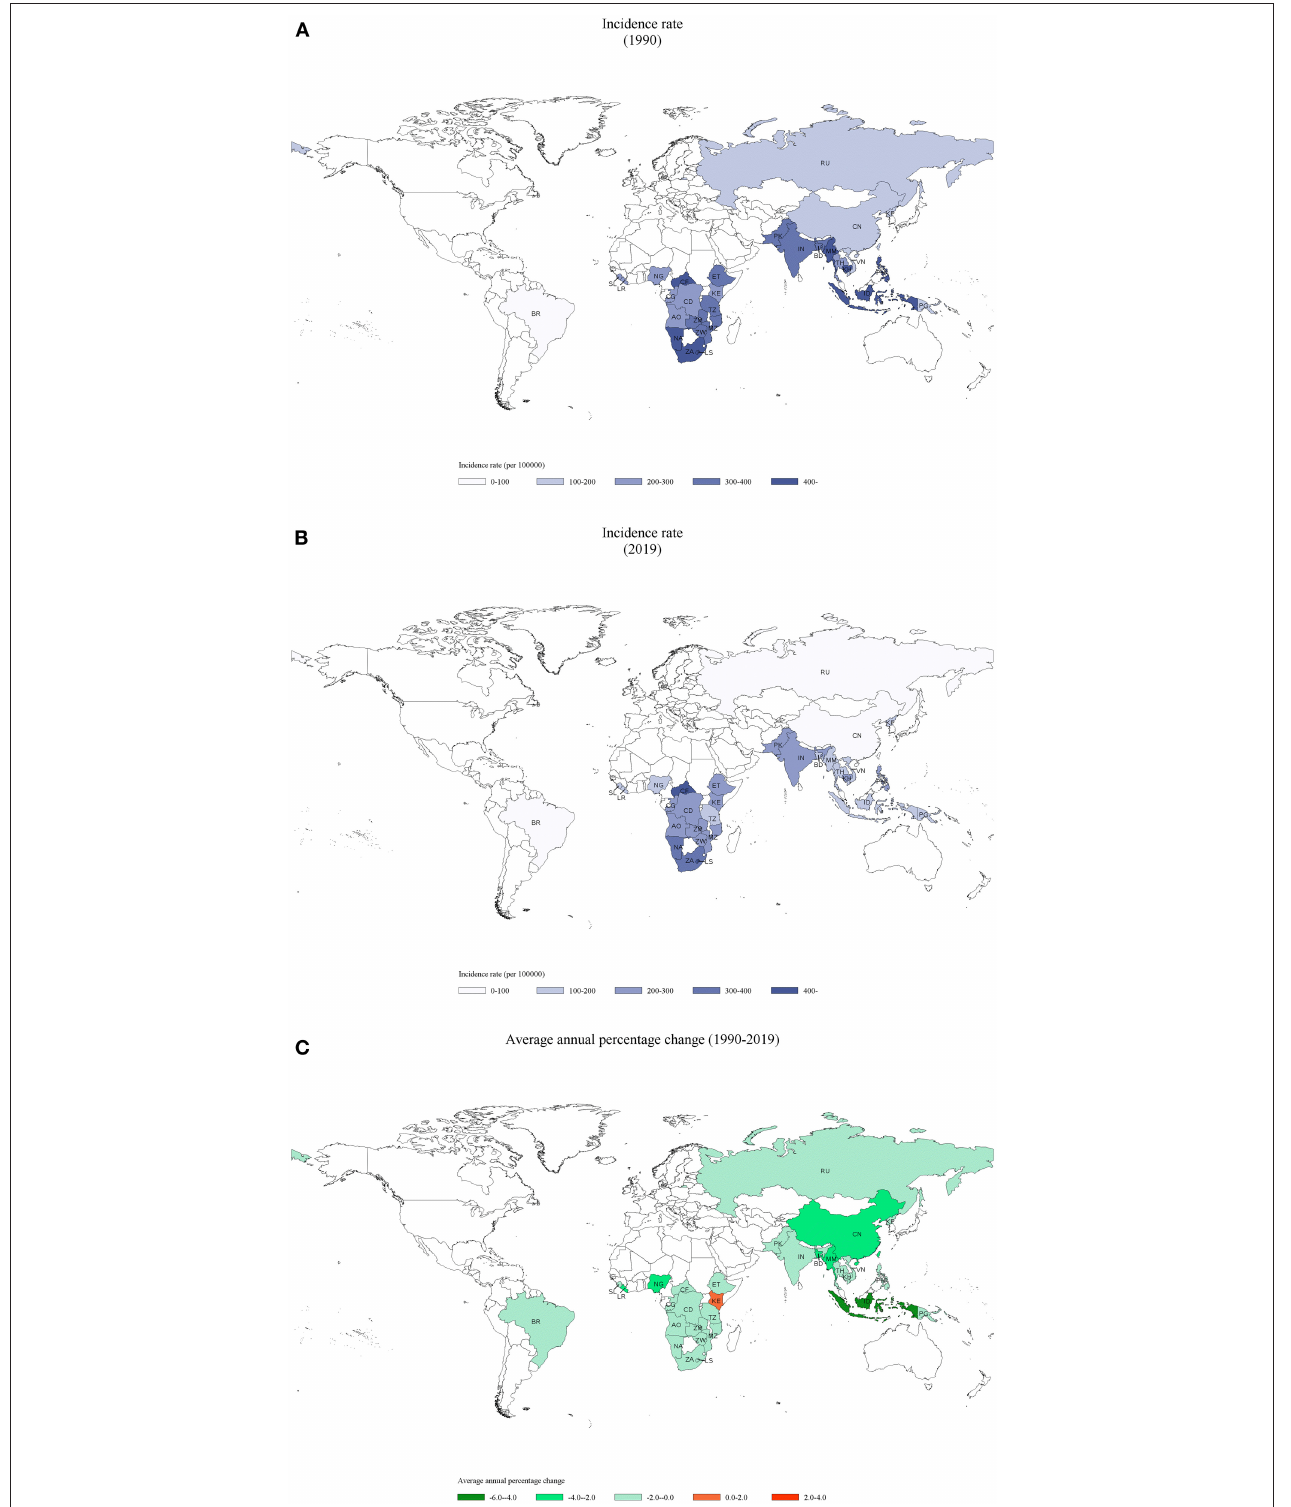
FIGURE 1 | Incidence of tuberculosis in 30 HBCs and its average annual percent change (AAPC): (A) the incidence rate in 1990, (B) the incidence rate in 2019, (C) the AAPC of incidence rate from 1990 to 2019. HBC, high burden country; AO, Angola; BD, Bangladesh; BR, Brazil; KH, Cambodia; CF, Central African